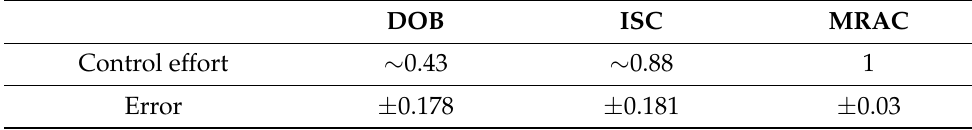
Table 2. Quantitative comparison between the